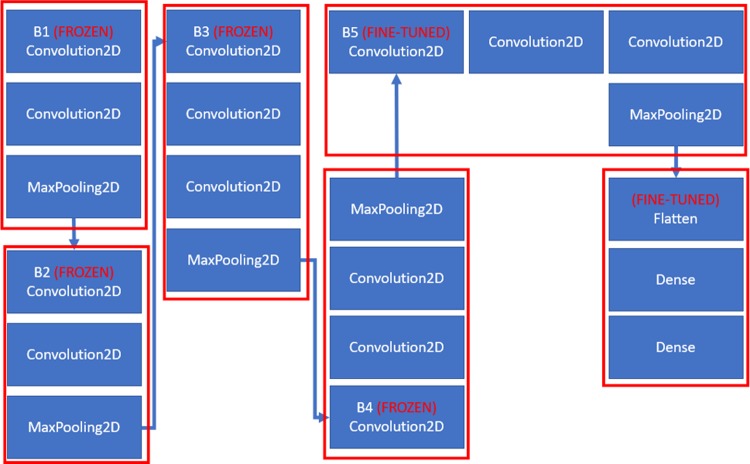
VGG architecture.